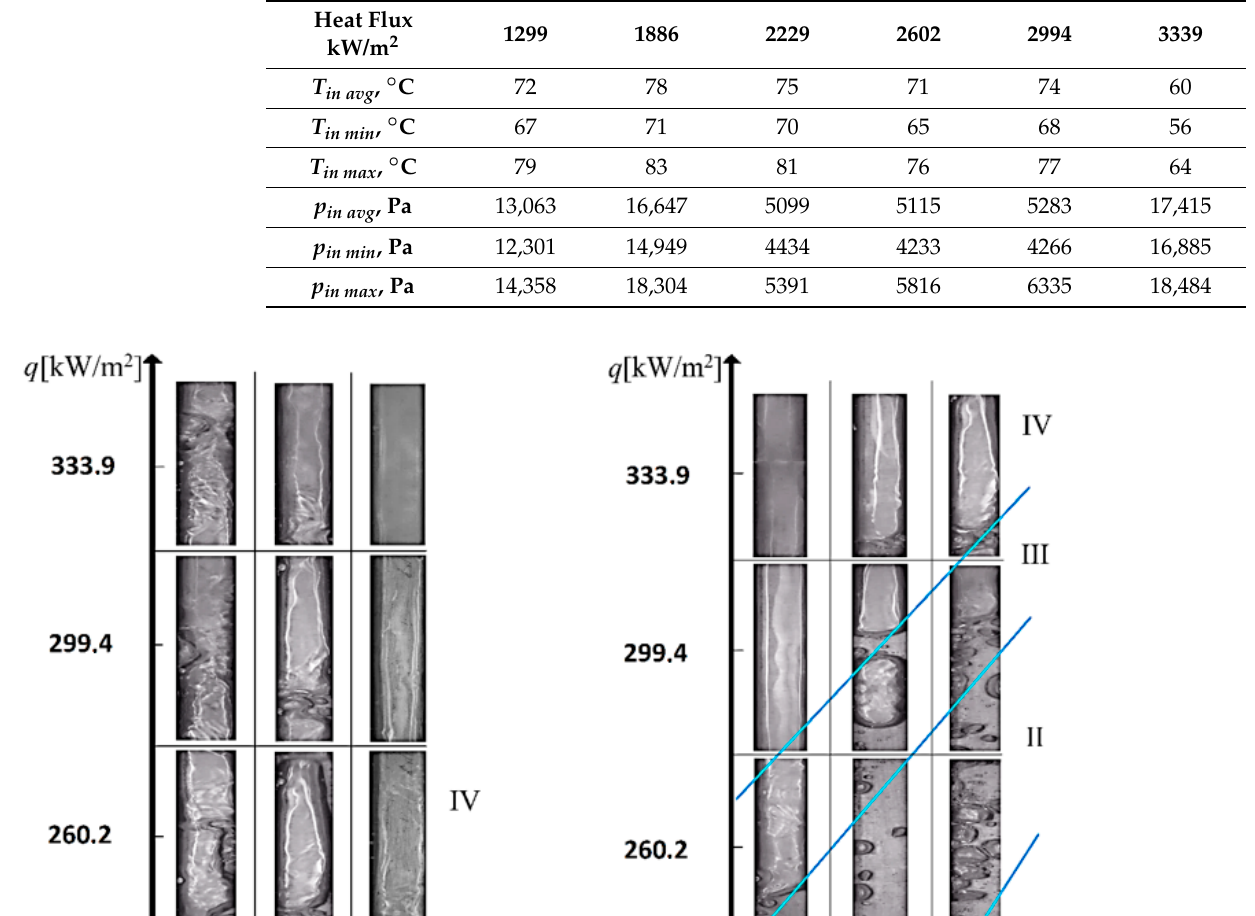
Table 6. Examples of inlet pressure and temperature variation for mass flux G = 4.69 × 10 − 9 kg/(m 2 s).